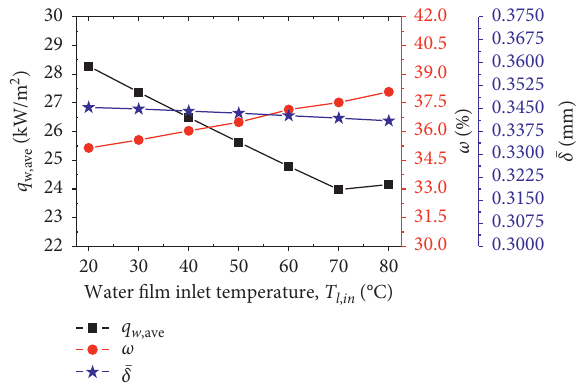
Figure 8: Influence of the water film inlet temperature on heat and mass transfer of the water film evaporation process.